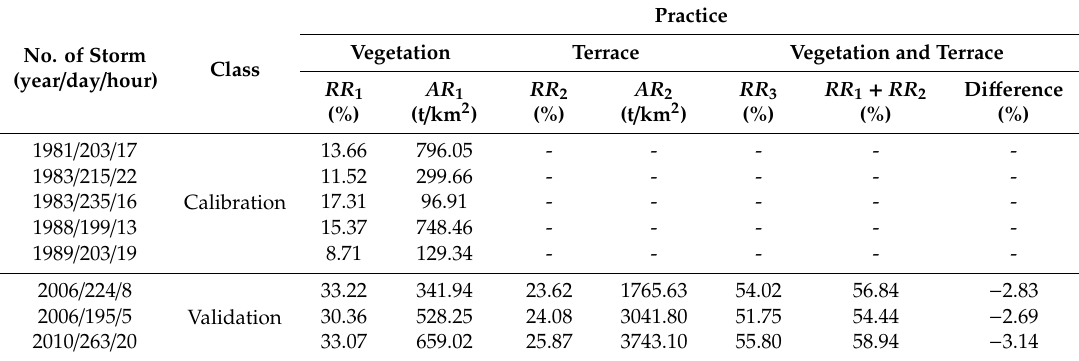
Table 7. The e ffi ciency of sediment reduction by vegetation and terraces in the Pianguanhe